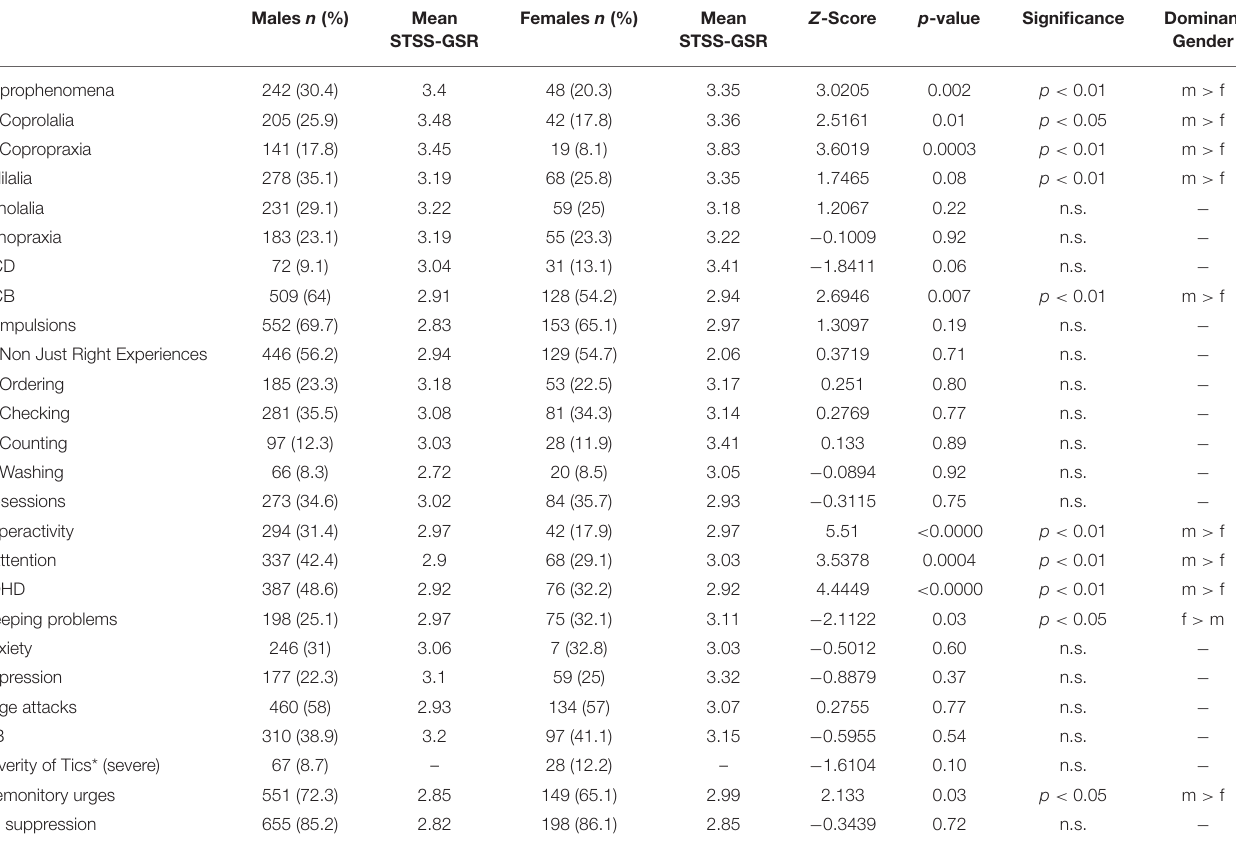
TABLE 9 | Gender differences in various TS-related aspects.